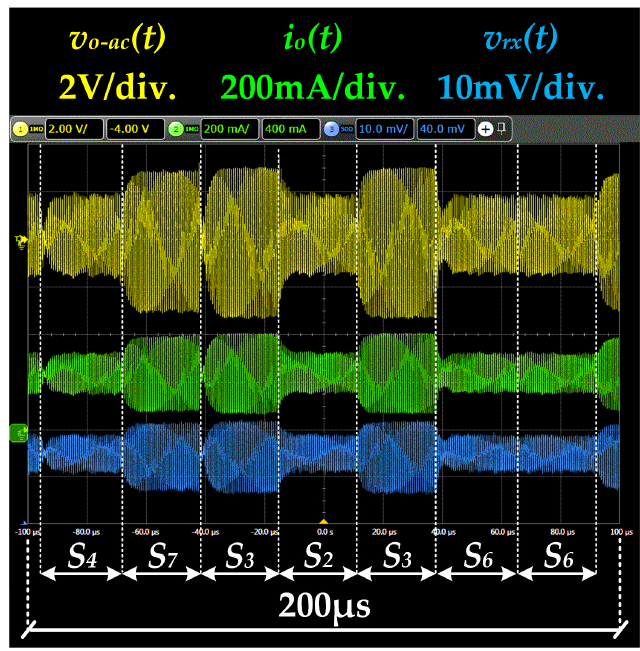
Figure 18. Main waveforms of the VLC link when the dc-biased 8-QAM scheme is reproduced. To further characterize the VLC system, the root mean square value of the error vector magnitude ( EVM RMS ) was evaluated. EVM RMS is a widely used figure-of-merit based on calculating the error vector for a sequence of N symbols, taking into account the average power of the transmitted ones: